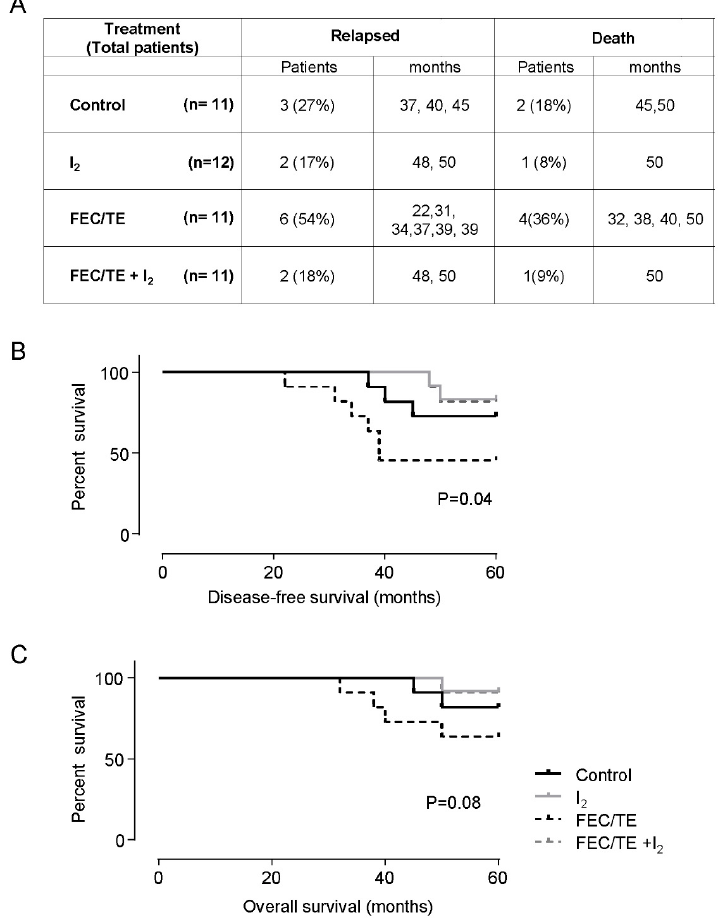
Figure 3. Recurrence and survival rate. ( A ) Patients who relapsed or died; number of patients and the months of relapse or death. ( B ) Analysis of disease-free curve; and ( C ) analysis of the overall survival curve. Kaplan-Meier analysis.